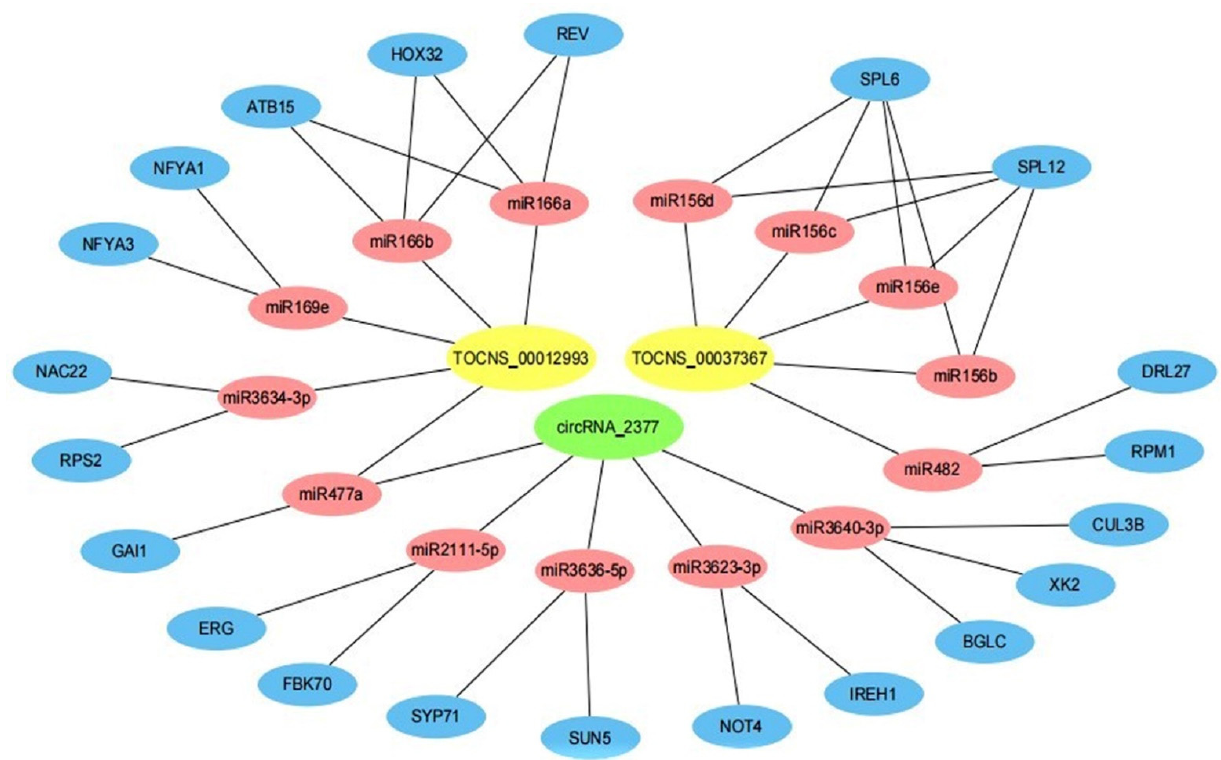
Figure 11. Prediction of interaction network among lncRNAs, circRNAs, miRNAs, and target genes. Yellow, green, red, and blue represent lncRNA, circRNA, miRNA, and target genes, respectively.